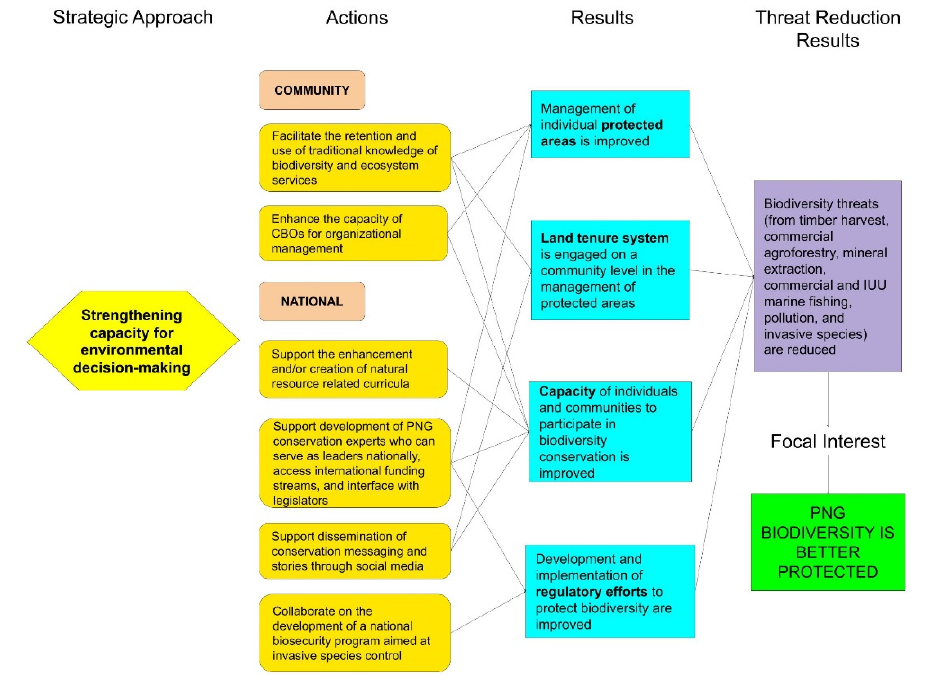
Figure 5. Results Chain for strategic goal of Strengthening Capacity for Environmental Decision-making in Papua New Guinea.